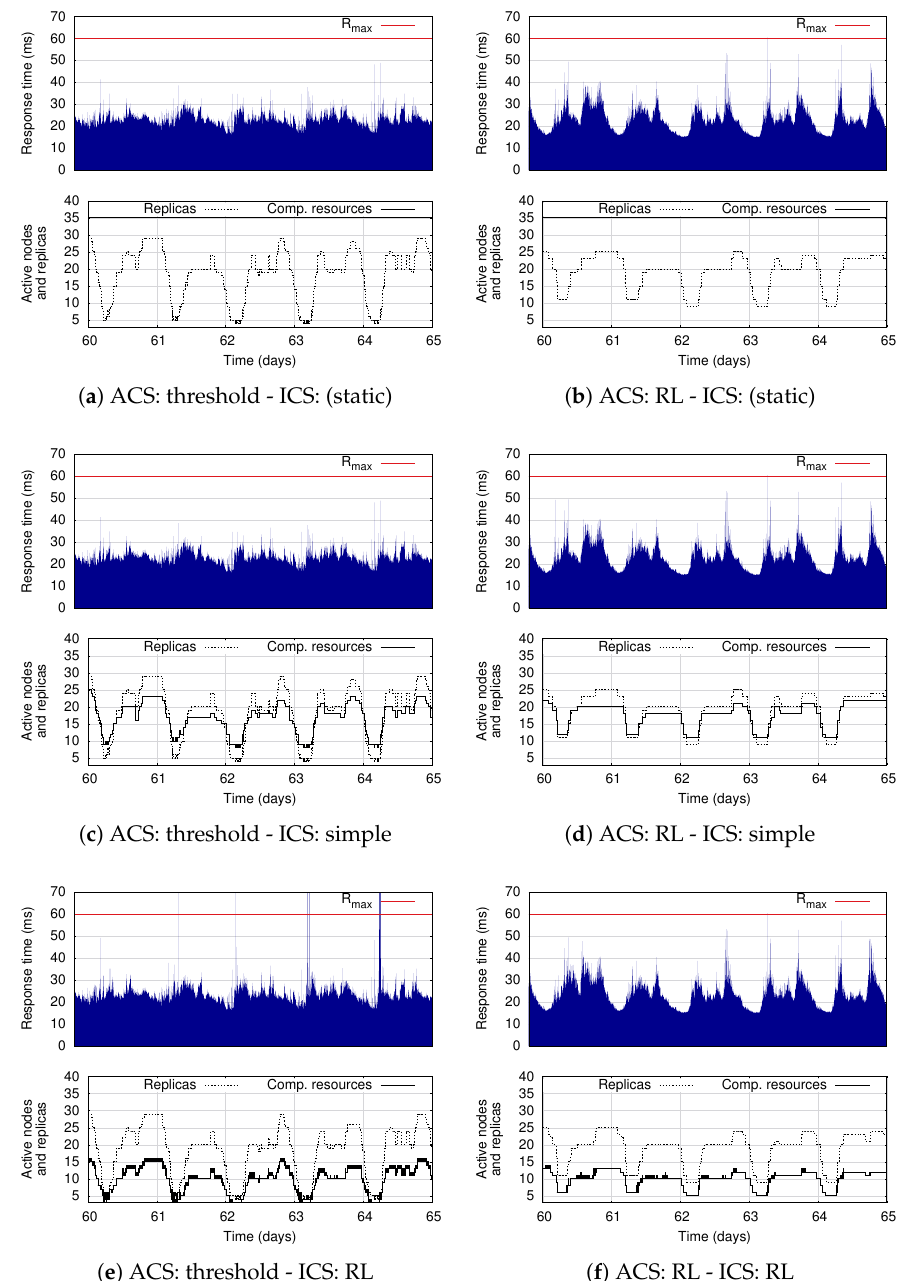
Figure 4. Application response time, number of operator replicas and active computing nodes during five simulated days at the end of the experiments, with different combinations of policies for ICS and